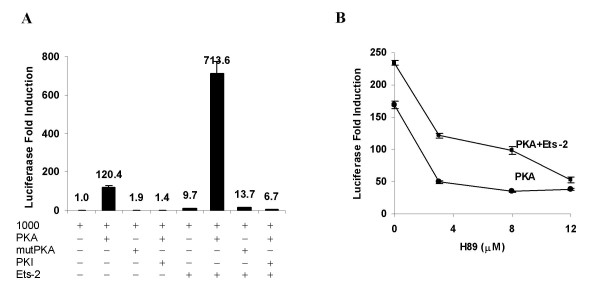
Effects of Ets-2 and activated PKA on the Tkdp-1 1000 bp promoter activity in JEG-3 cells. Expression of the 1000 bp promoter-Luc construct A) following co-transfection with activated PKA, activated PKA+PKI, mutPKA, Ets-2, Ets-2+activated PKA, Ets-2+activated PKA+PKI, Ets-2+mutPKA and B) in cells exposed to the PKA inhibitor H89 in presence and absence of co-transfected Ets-2. Luc activities are expressed relative to that of the basal activity of the 1000 bp construct and data are shown as mean ± SEM (n = 3). The following values are significantly different at P < 0.05: A) 1000 vs. 1000+PKA, 1000+Ets-2, 1000+Ets-2+PKA; 1000+PKA vs. 1000+mutPKA, 1000+PKA+PKI; 1000+Ets-2+PKA vs. 1000+Ets-2+mutPKA, 1000+Ets-2+PKA+PKI and B) 1000+PKA vs. 1000+PKA+3 μMH89, 1000+PKA+8 μMH89; 1000+PKA+12 μM H89; 1000+Ets-2+PKA vs. 1000+Ets-2+PKA+3 μM H89, 1000+Ets-2+PKA+8 μM H89, 1000+Ets-2+PKA+12 μM H89